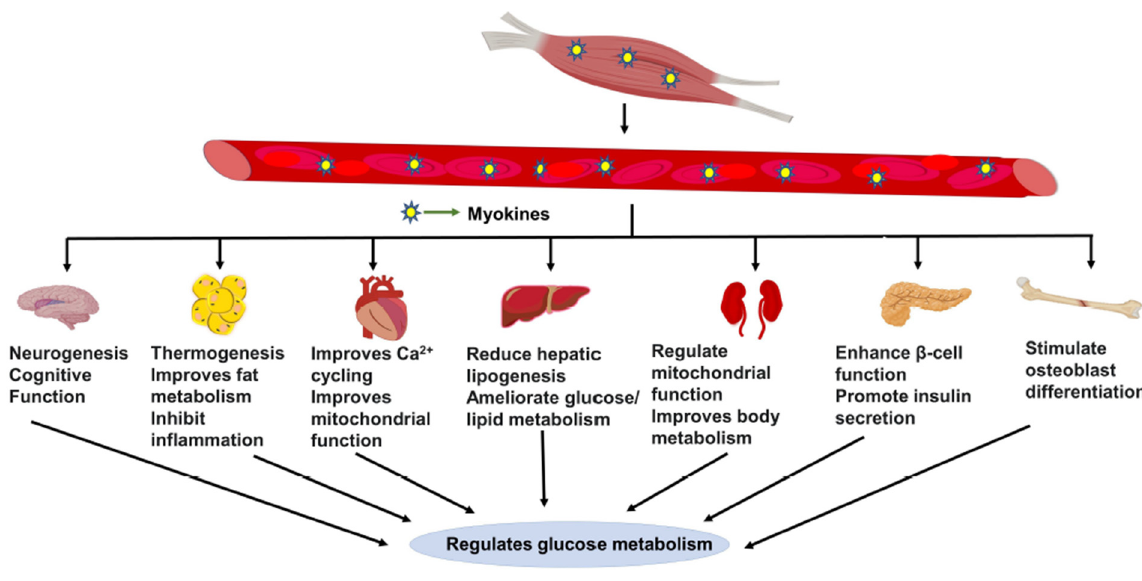
Figure 2. Myokine-mediated systemic regulation. Skeletal muscle-secreted myokines are involved in cross-talk with other internal organs to regulate cognitive function, stimulate osteoblast differentiation, enhance islet β -cell function, promote insulin secretion, regulate mitochondrial function, increase lipolysis and promote glucose oxidation. Through their role in organ cross-talk and systemic regulation of energy metabolism, myokines hold substantial promise for reducing inflammation and reducing the risk of insulin resistance and type 2 diabetes. This figure was created with Bioren- der.com.